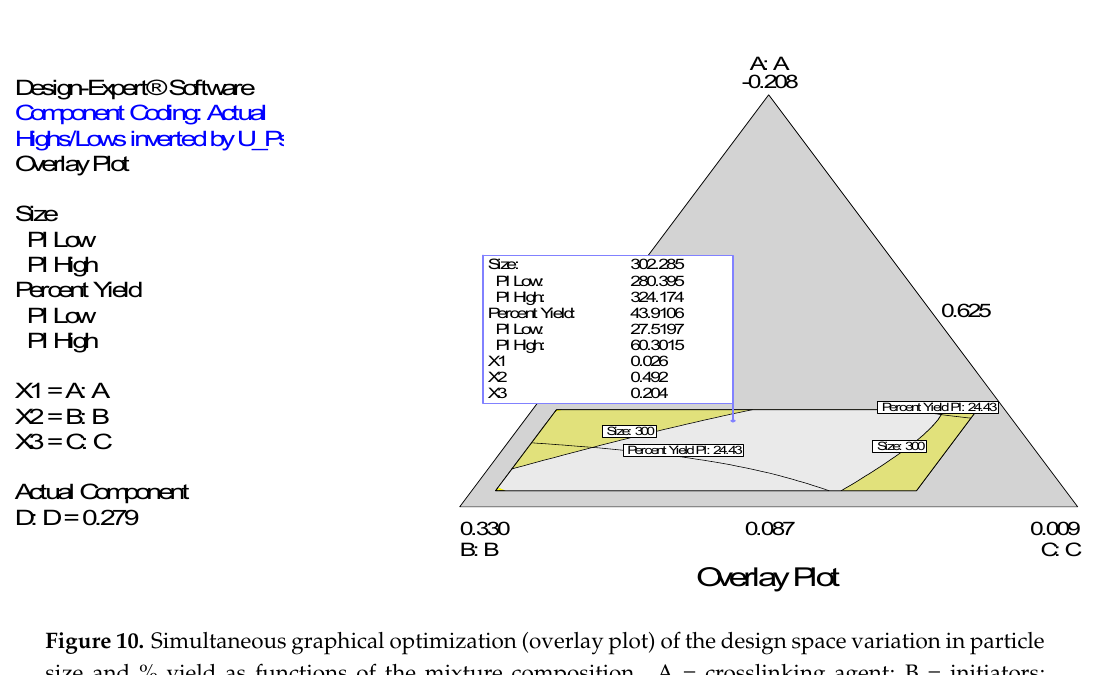
Figure 10. Simultaneous graphical optimization (overlay plot) of the design space variation in particle size and % yield as functions of the mixture composition. A = crosslinking agent; B = initiators; C = stabilizer and D = macromonomer.